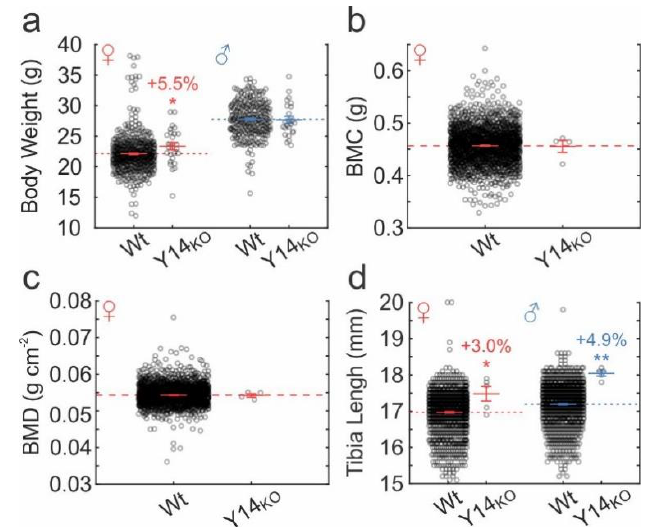
Figure 6. Skeletal phenotype of P2Y 14 mutant mice. Wt and Y14 KO mouse phenotype data were obtained from the IMPC database. ( a ) body weight (9 week-old mice). n = 288–556 Wt, 24–27 KO mice / sex. ( b ) Bone mineral content, BMC (13–14 week-old mice). n = 1814 Wt, 4 KO mice. ( c ) Bone mineral density, BMD (13–14 week-old mice). n = 1807 Wt, 4 KO mice. ( d ) Tibial lengths (13–14 week-old mice). n = 1061–1093 Wt, 5 KO mice / sex. Raw data and means ± sem are shown. Significance was assessed by pairwise t-test; * p < 0.05 or ** p < 0.01.